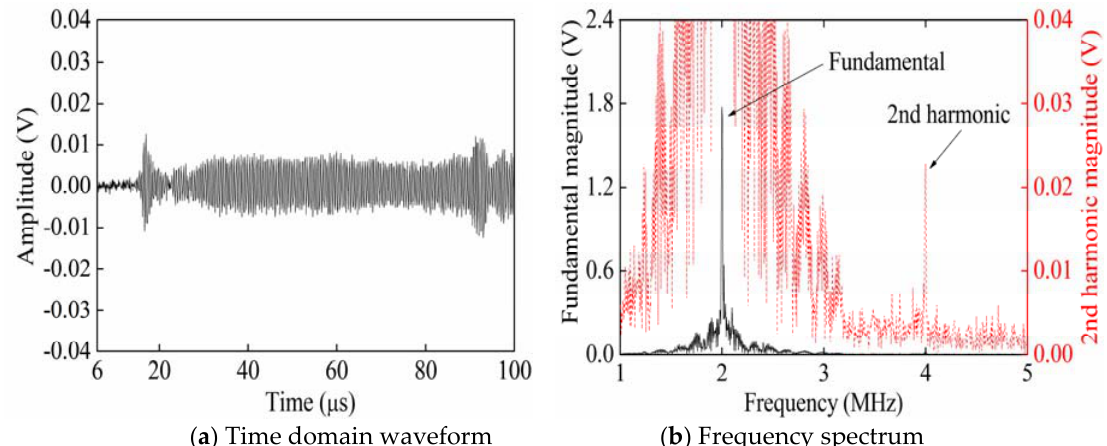
opening Channel 2.